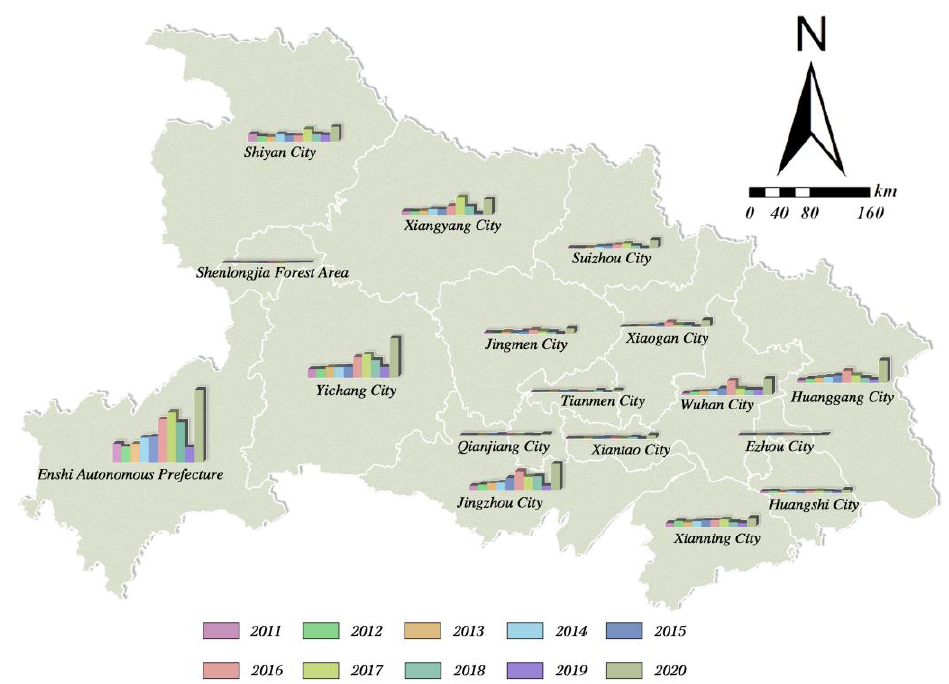
Figure 5. Net assets of water resources in Hubei Province from 2011 to 2020.